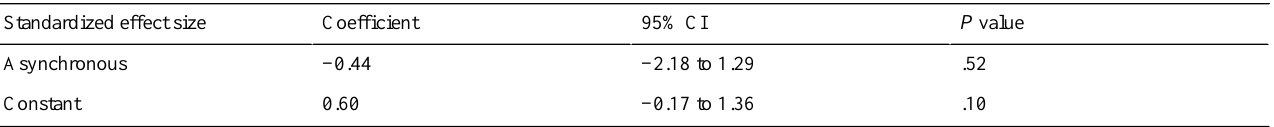
Table 2. Metaregression of synchronous and asynchronous dietary interventions on behavior change outcome, analyzed using standardized effect